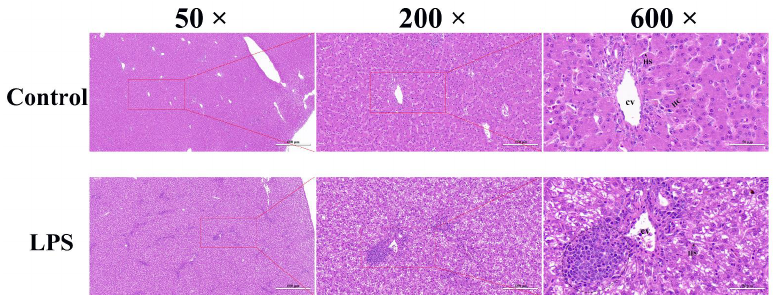
Figure 1. Histological observations of goose livers (50×, 200×, and 600×): CV: Central vein; HS: Hepatic sinusoid; HC: Hepatic cord; Oval area: Inflammatory cell infiltration. 3.2. Effects of LPS on the Liver Biochemical Indices of Goose In two groups, the levels of ALT and AST in the livers of geese were measured, and